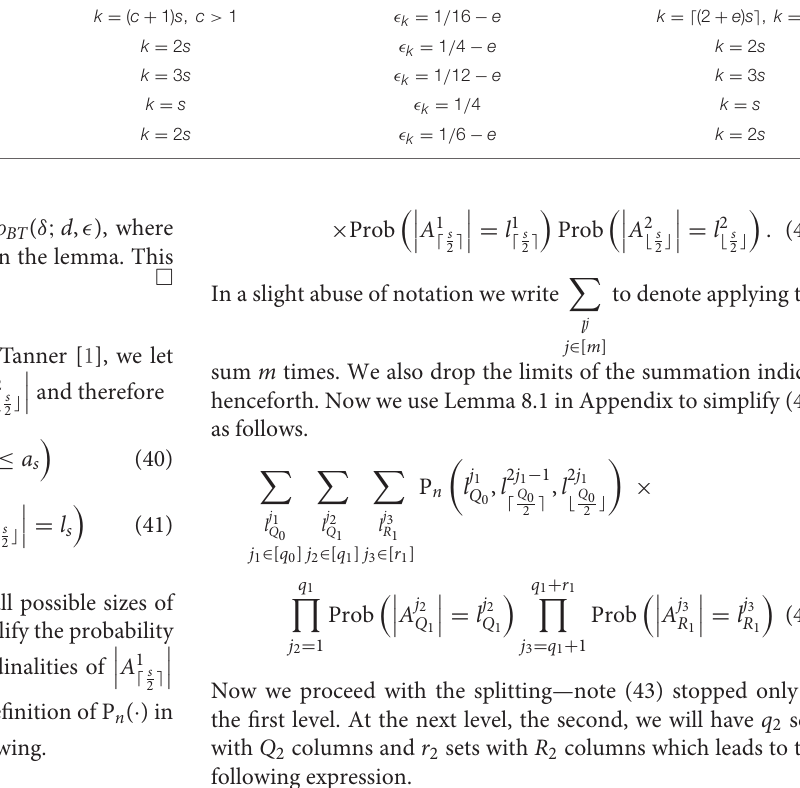
TABLE 1 | Recovery conditions on ǫ . Algorithm